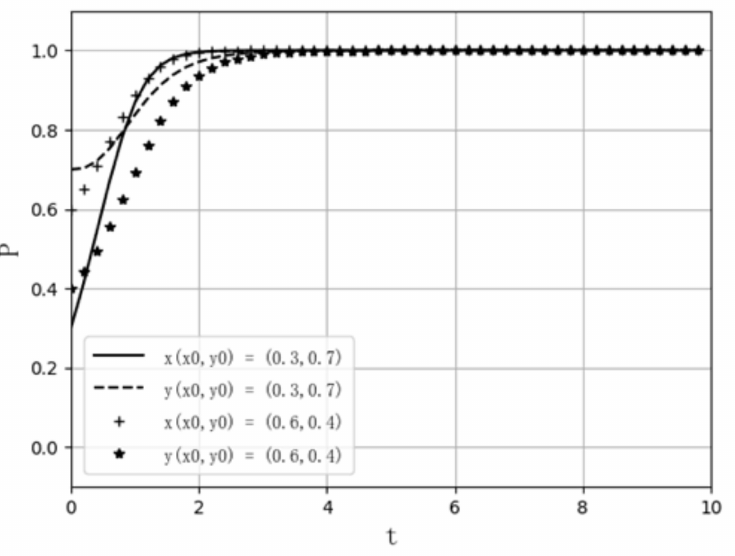
Figure 3. Path diagram of the evolutionary game on abandoned land transfer between farmers and agricultural enterprises under constraints ( I 2 + B < I 3 − C and point E located at the lower left).